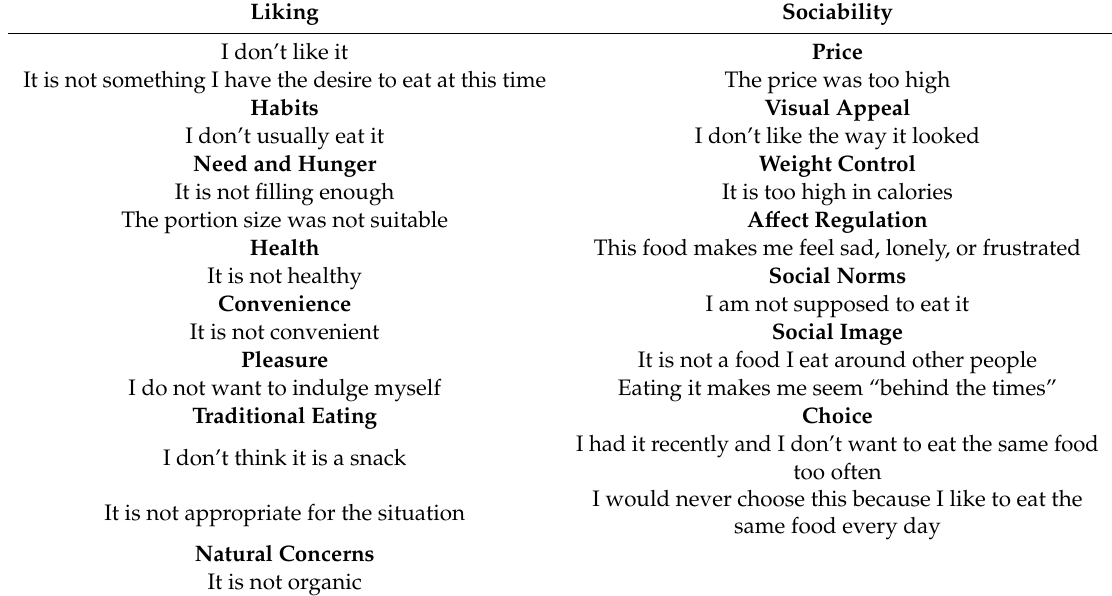
Table 3. 16 eating motivation constructs and their corresponding negative sub-items that were used in